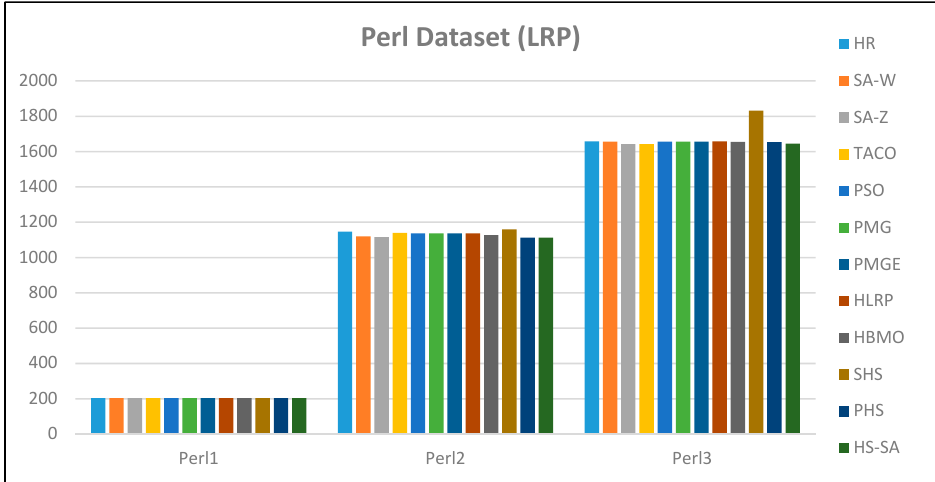
Figure 3. Best result of Perl dataset for LRP. Appl. Sci. 2020 , 10 , x FOR PEER REVIEW